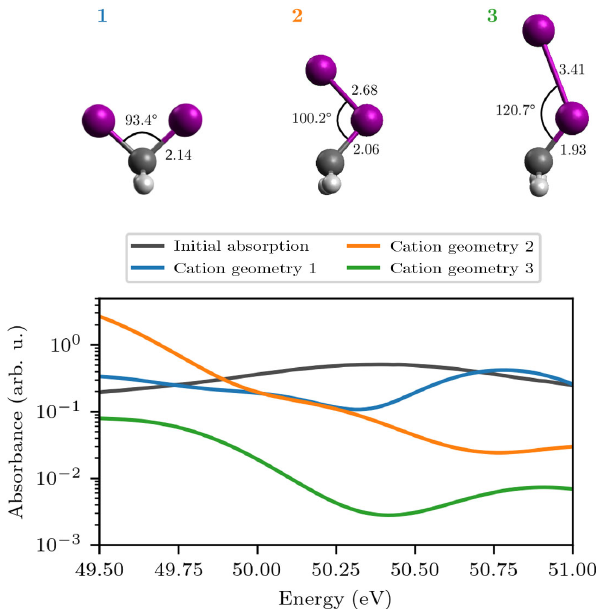
FIG. 4. Theoretically calculated absorption spectra for the different geometries of the di-iodomethane cation, as well as the measured absorption spectrum of neutral di-iodomethane. Note the logarithmic scale. Geometry 1 represents the arrange- ment of the nuclei in the cationic ground state. Geometries 2 and 3 are the minimum-energy structures along the molecule ’ s dissociation path passing through the isomeric geometry (numeri- cal input data for the different geometries were obtained from Ref. [45]). All distances are given in